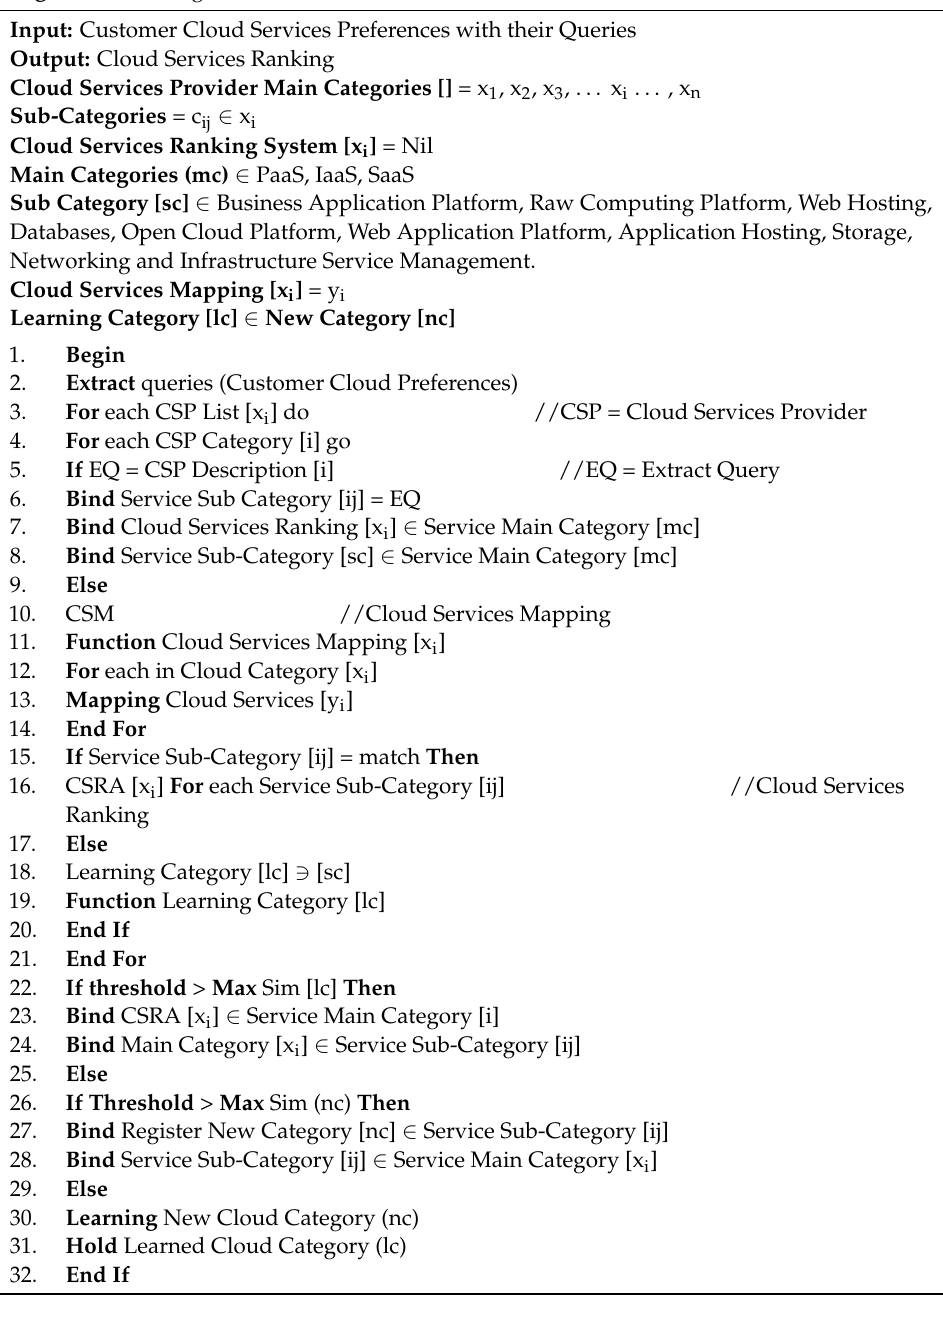
Algorithm 2. Categorization of Cloud